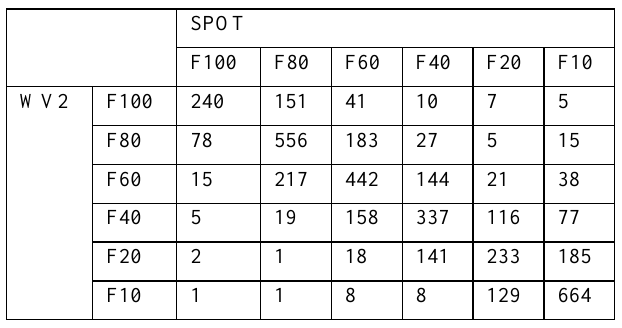
Table 2. Confusion matrix of classification with SPOT simulating Sentinel-2A in comparison to Worldview-2.